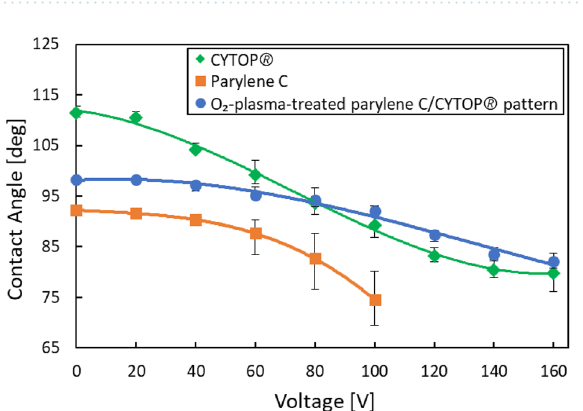
Figure 5. Experimental results of height control of a droplet by electric field for EWOD. A 4 µl DI water droplet is prepared on a circular pattern for a droplet. Side views of the droplet are observed as the applied voltage is turned off and on. The height of the DI water droplet is successfully decreased through the application of an electric field. The height of the droplet, which is 1290 μm in the initial state, decreases to 1101 μm when a voltage of 160 V is applied, as shown in this figure. The height of the droplet increases when the applied voltage is turned off.